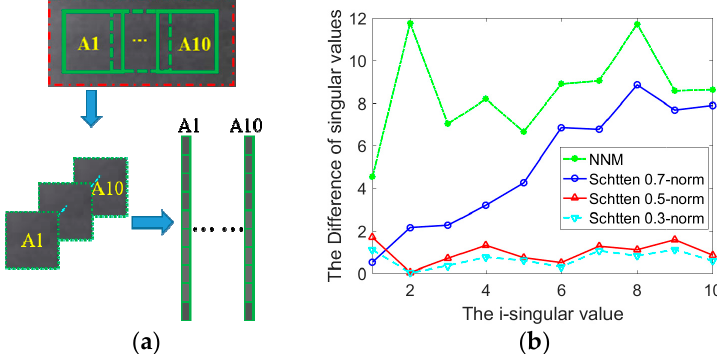
Figure 2. Illustration of the low-rank approximation using different rank function. ( a ) Construction of local patch-image A clipped in Figure 1a. ( b ) Degree of the deviation between singular values recovered by different rank functions and the original ones.